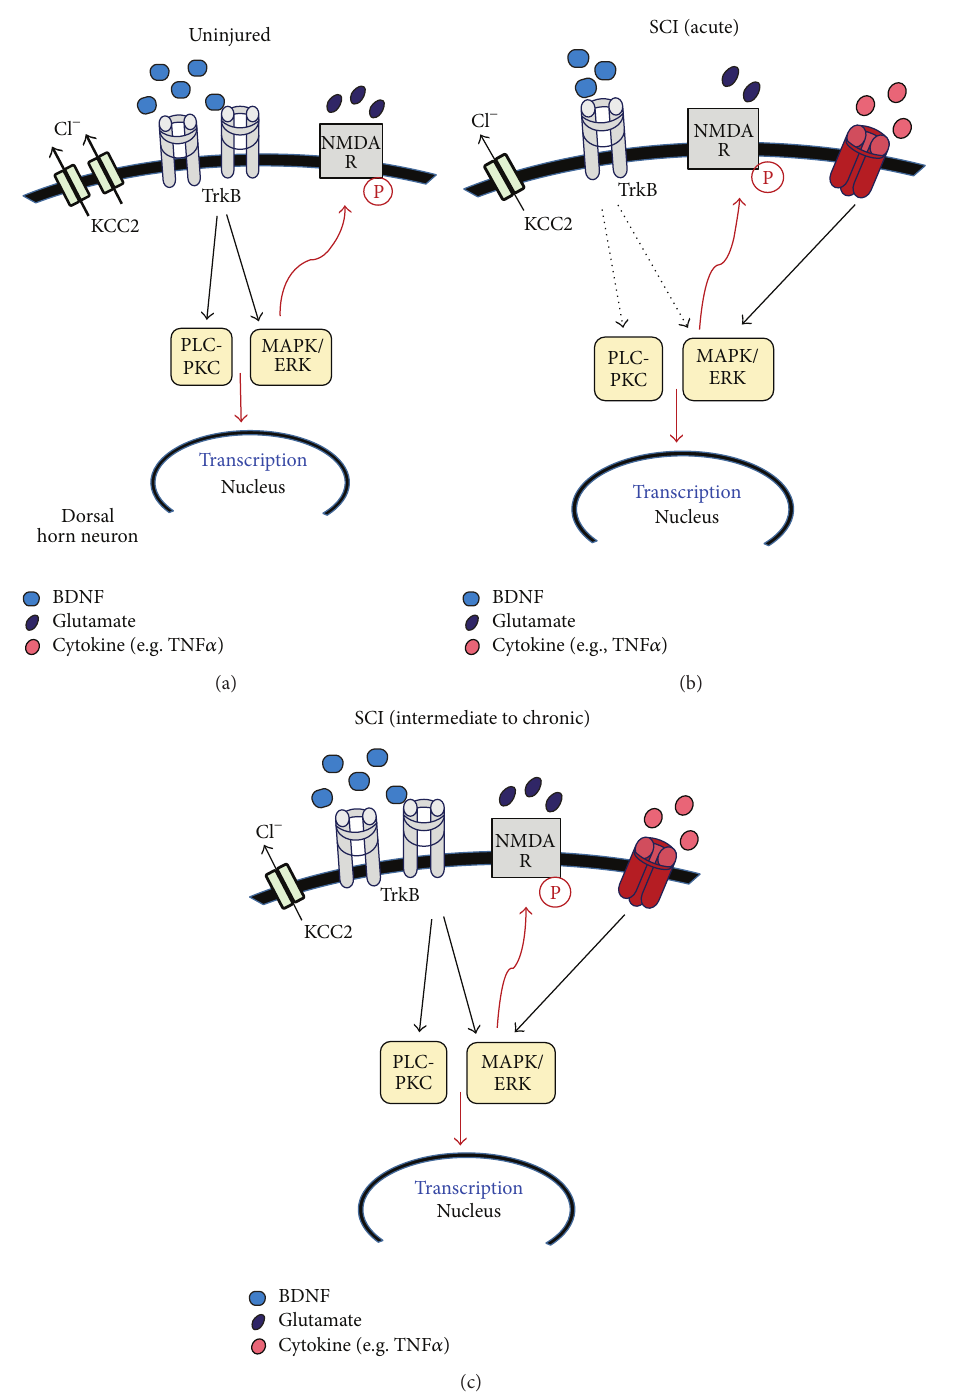
Figure 8: Potential BDNF-dependent and BDNF-independent mechanisms of pain in uninjured and injured spinal cord. (a) In the absence of SCI, BDNF-mediated effects contribute to pain. Constitutive increases in BDNF and TrkB expression activate MAPK/ERK and PLC-PKC kinase pathways, which in turn leads to transcription of pain genes and posttranslational modifications (e.g., phosphorylation of glutamate receptors). (b) In the acute stage of SCI, both BDNF and TrkB levels are decreased in the spinal cord dorsal horn [93]. However, during this stage, MAPK/ERK pathways could be activated by BDNF-independent mechanisms, presumably an alternate pathway such as the TNF 𝛼 pathway (both TNF 𝛼 and TNR1 expressions are upregulated by SCI [94]). A decrease in KCC2 by SCI which alters GABA-mediated chloride function is likely to also contribute to pain after SCI. (c) During the chronic stage of injury, pERK levels are increased [94, 95], which may result from increases in both BDNF-TrkB signaling and TNF 𝛼 -TNFR signaling. Activation of these pathways could consequently increase kinase activity and the transition of pain genes. Overall, we propose that although BDNF may not necessarily initiate pain-producing pathway after SCI, it is likely to contribute to pain hypersensitivity during the chronic stages of